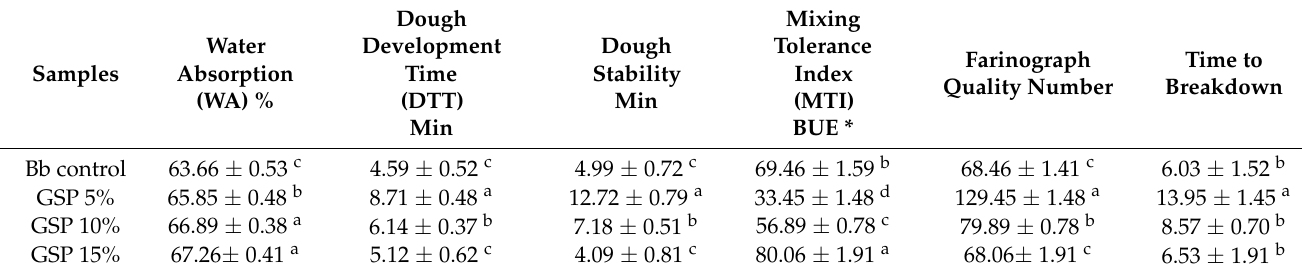
Table 4. Farinograph parameters of balady bread dough supplemented with different ratios of GSP.